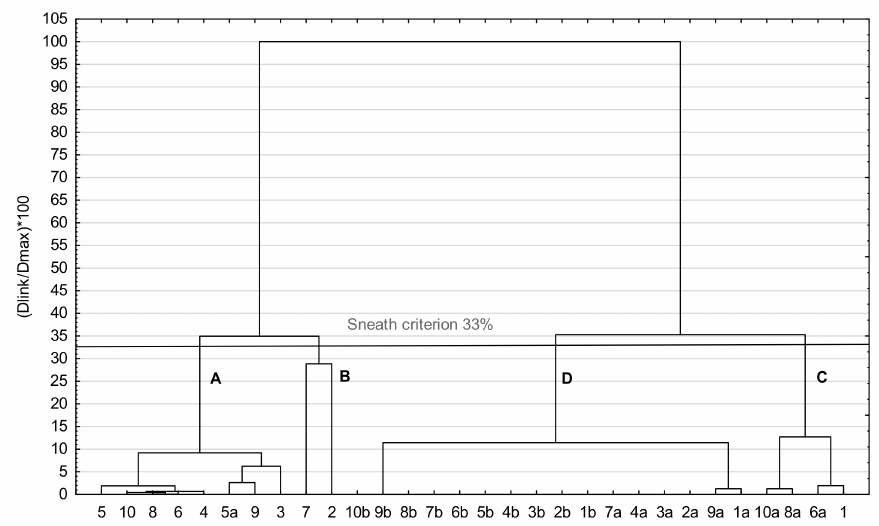
Figure 3. Dendrogram presenting the similarity of compounds in terms of their biological activity against the tested fungal strains: Candida albicans ATCC 10231, Candida albicans ATCC 3002, Candida albicans clinical isolate 26 and Candida albicans clinical isolate